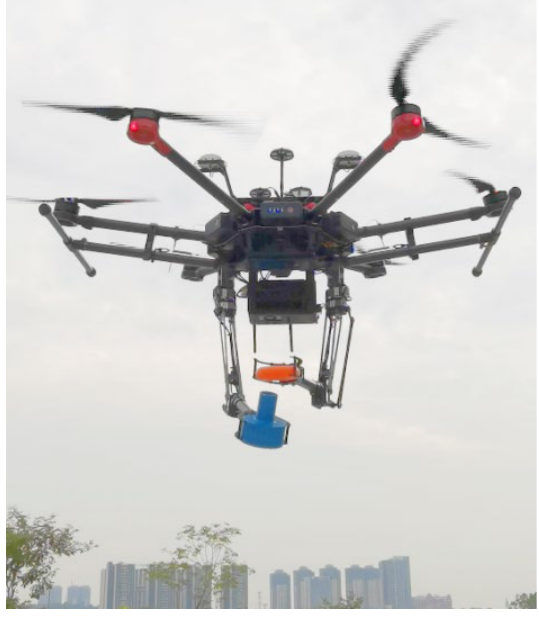
Figure 1. Dual-arm manipulator system for aerial cooperative bimanual manipulation.